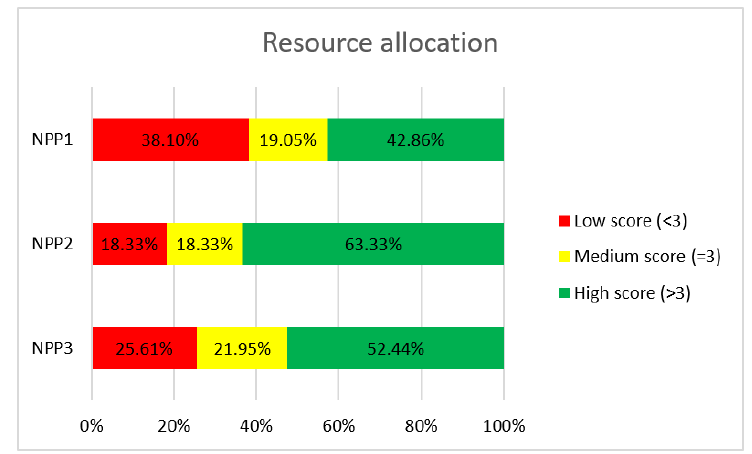
Table 8. Descriptive statistics of the scales by work location. Figure 8. Categorized BARS percentages for resource allocation by company. Figure 8. Categorized BARS percentages for resource allocation by company.